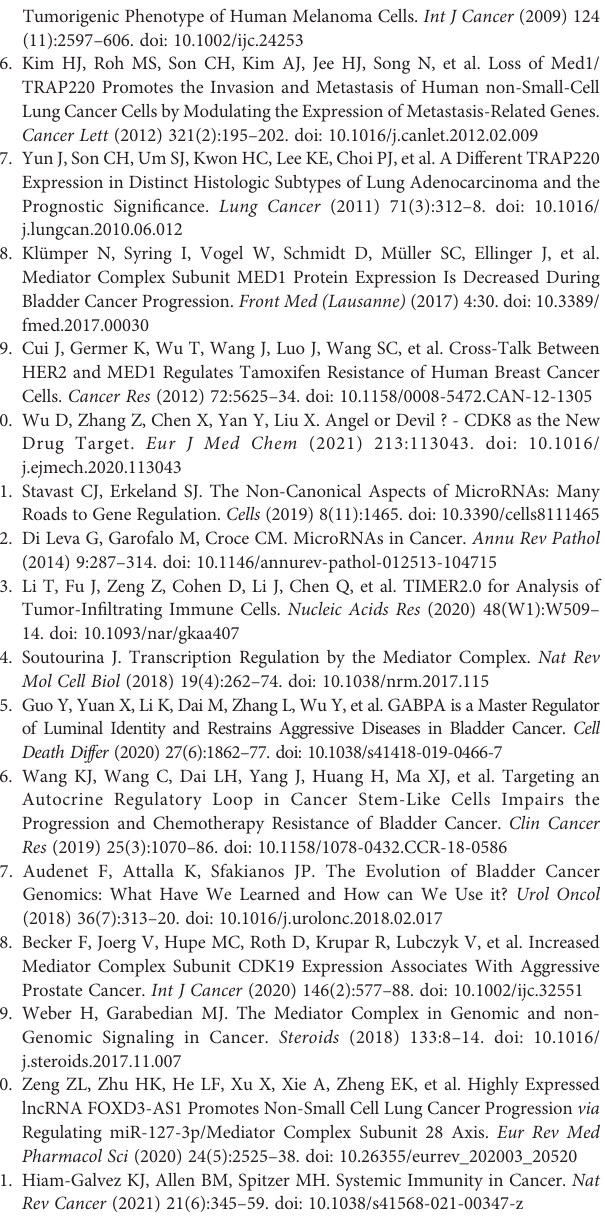
Supplementary Figure 1 | The MED10/MIR590 signaling plays a critical role in stem cell population maintenance and cell fate determination. GO term enrichment was based on biological function. GO, gene